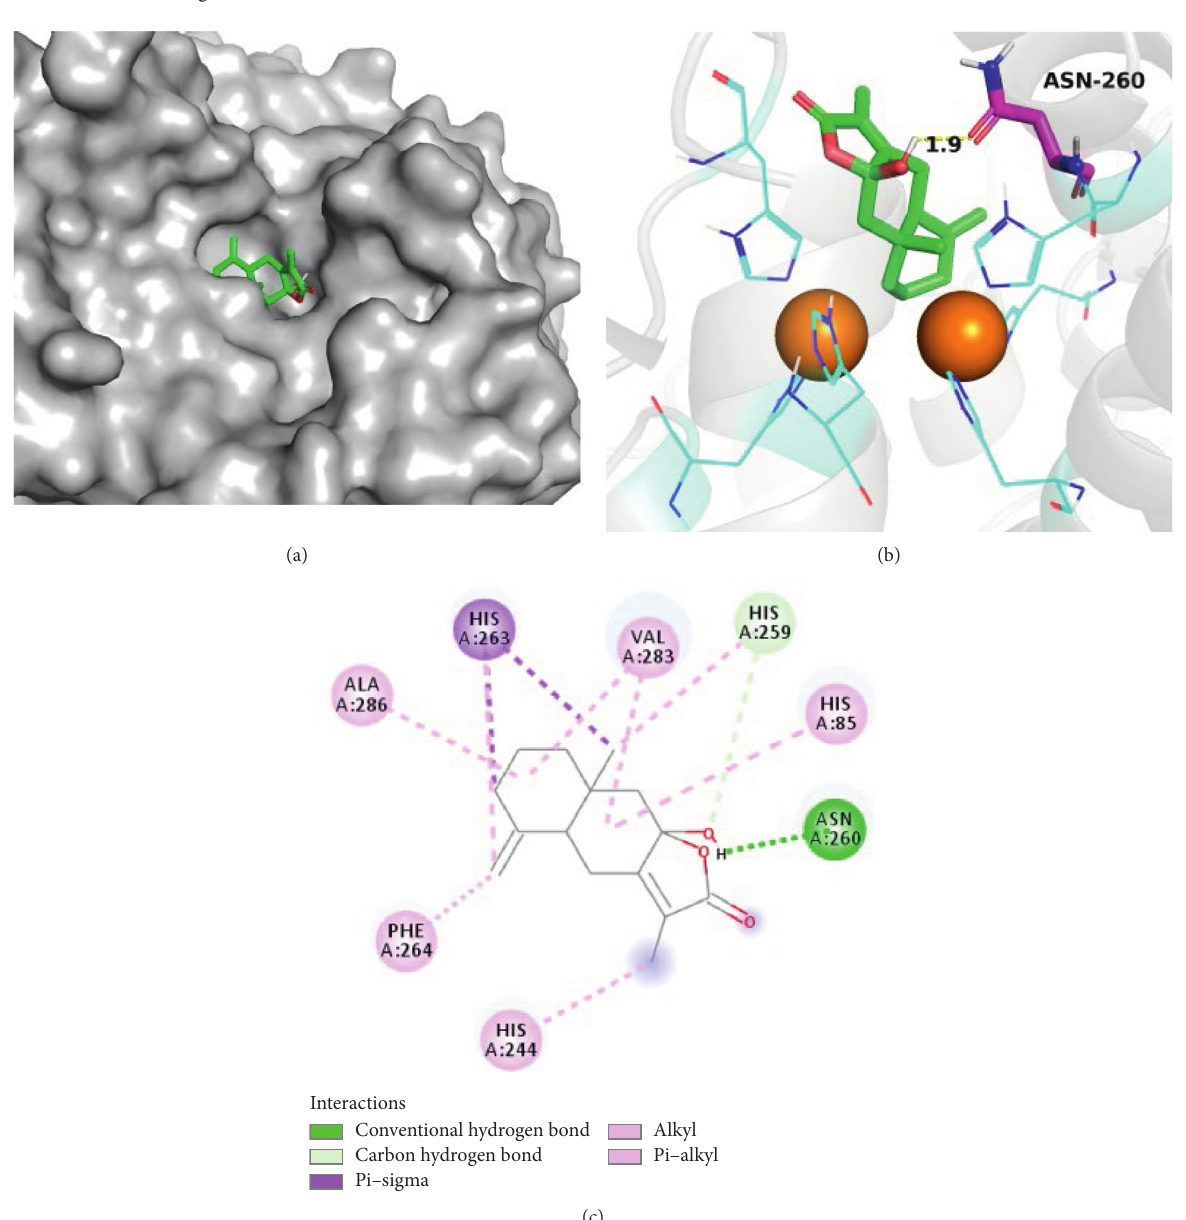
Figure 6: (a) Docking model of atractylenolide III in the mushroom tyrosinase ligand binding pocket. (b) 3D ligand-receptor interactions of atractylenolide III with the mushroom tyrosinase. (c) 2D ligand-receptor interactions of atractylenolide III with the mushroom